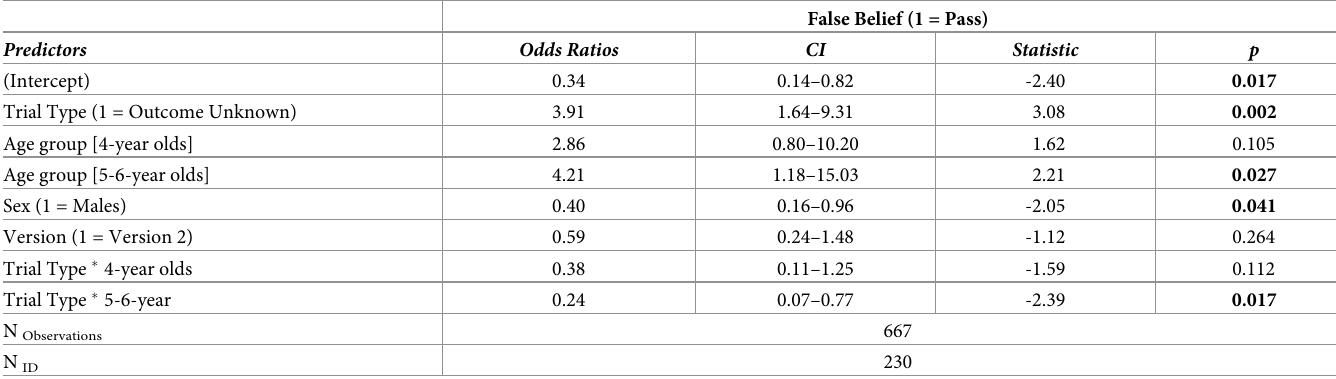
Table 3. Mixed effect logistic regression with a random intercept for participant predicting false belief